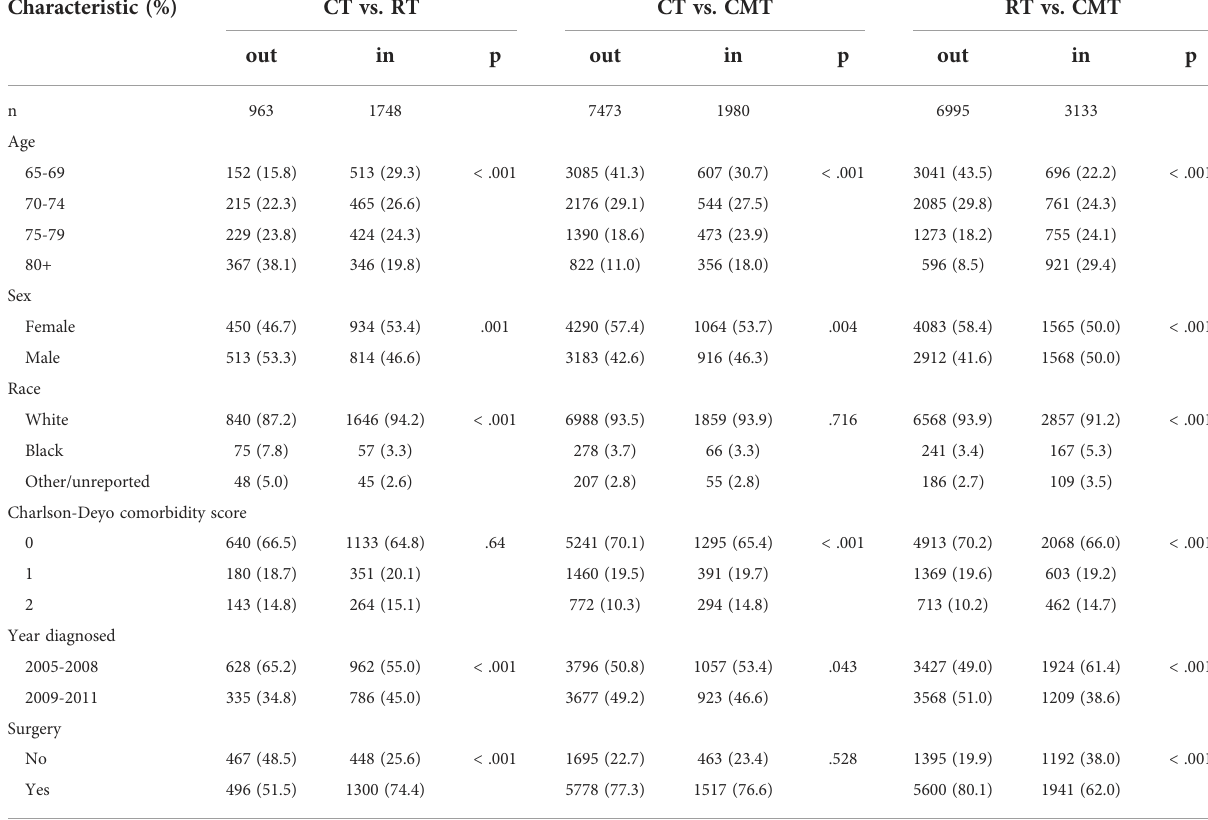
TABLE 2 Glioblastoma patient characteristics by treatment and match status based on logistic regression propensity scores. Characteristic (%) CT vs. RT CT vs. CMT RT vs.